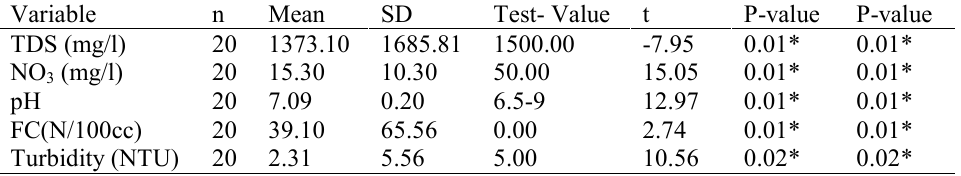
Table 2. Comparison of average groundwater quality parameters of the study area and drinking water standard in Iran Variable n Mean SD